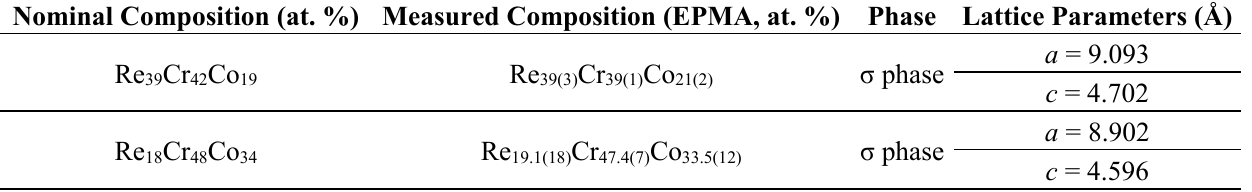
Table 2. Re–Cr–Co samples synthesized in this work (new